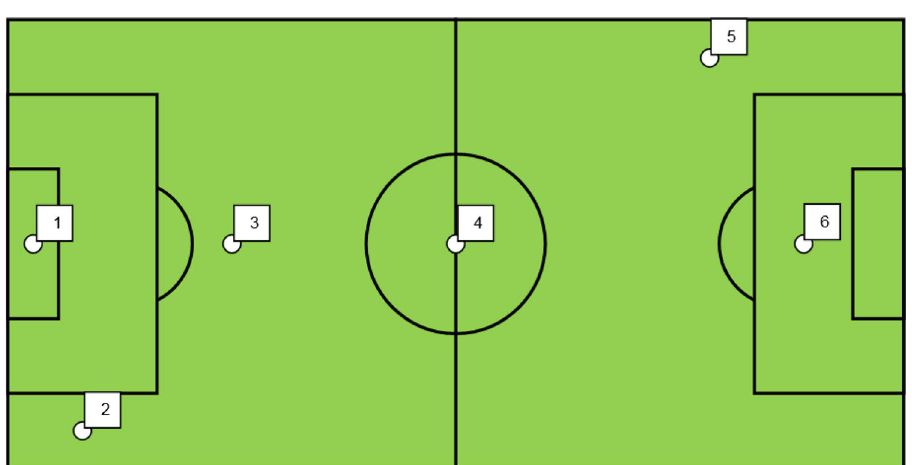
Figure 2. Scheme of distribution of granulate sampling points on a sport field. Designation: location and numbers of granulate sampling points.